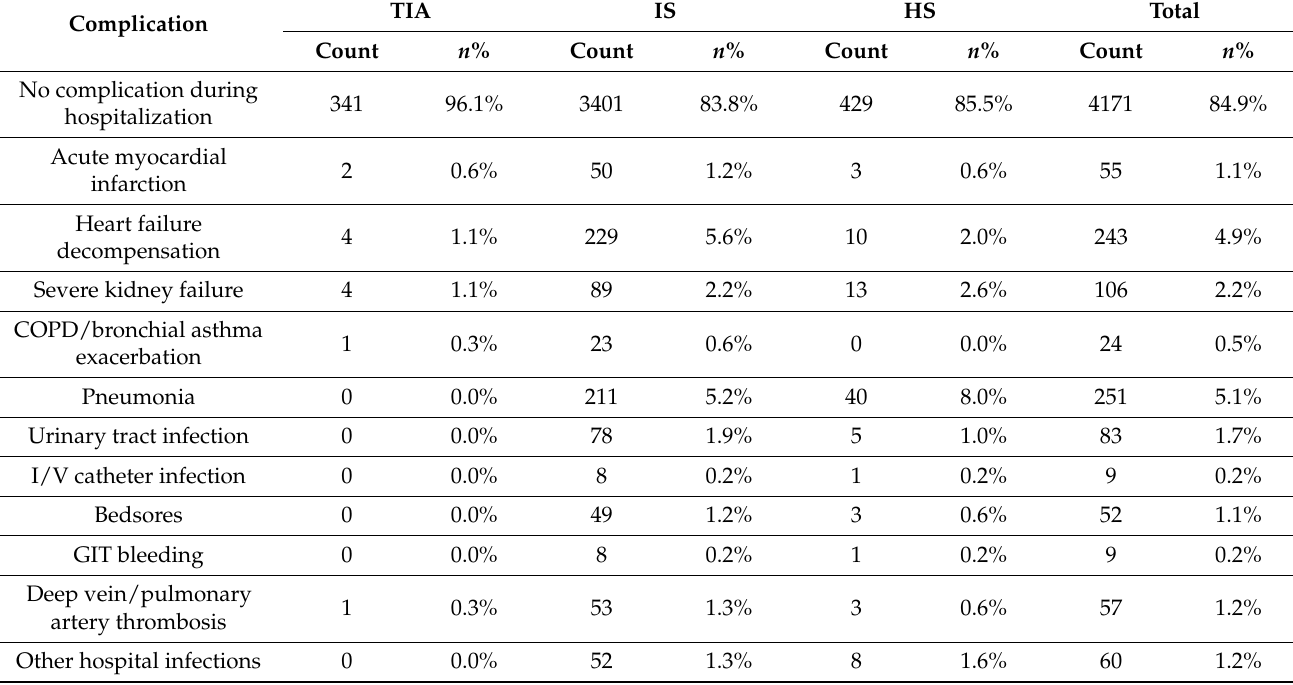
Table 5. Stroke complications during hospitalization.